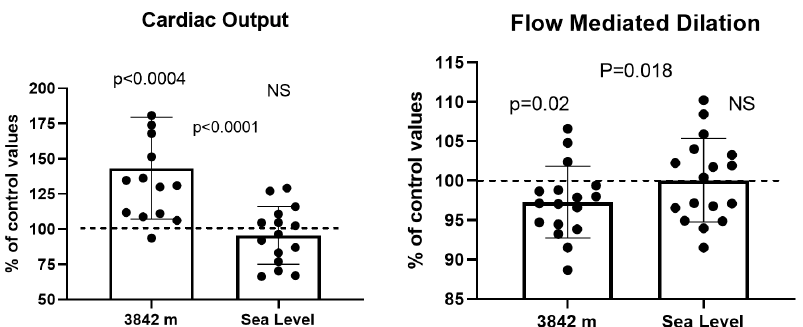
Figure 3. Cardiac output changes and flow-mediated dilation. Results are presented in relative values, at 3842 m and 1 h after return to normobaric conditions compared to pre-ascent values. Results are presented as mean ± SD. NS p > 0.05.